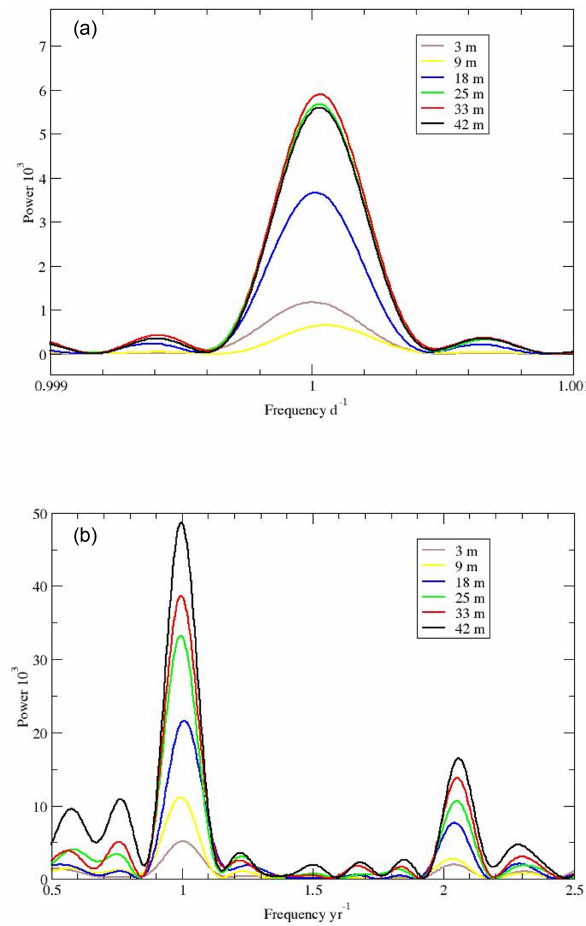
Figure 10. Harmonic analysis of the 2014–2019 wind speed time series near diurnal (a) and annual/semi-annual (b) frequencies.